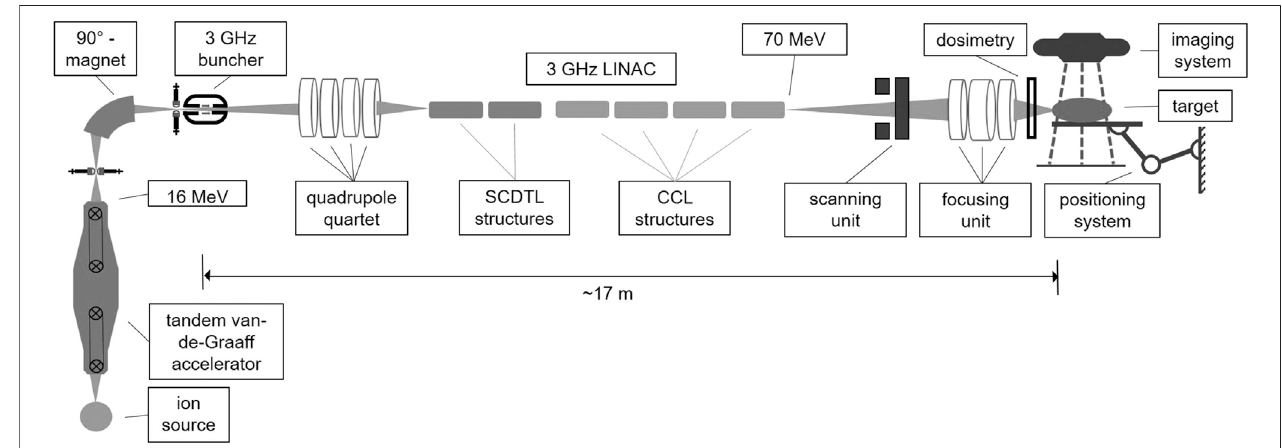
FIGURE 1 | Scheme of the proposed tandem-LINAC system including matching unit, focusing stage as well as an imaging and target positioning system.